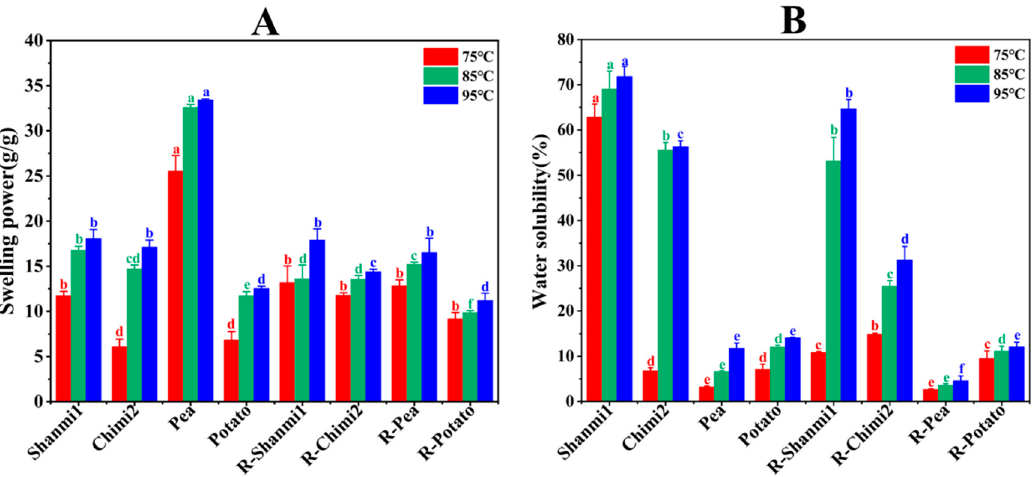
Figure 4. ( A ) Swelling power of NS (natural starch) and RS (resistant starch); ( B ) Water solubility of NS (natural starch) and RS (resistant starch). The error bars (a–f) indicate the standard errors of the means ( n = 3).